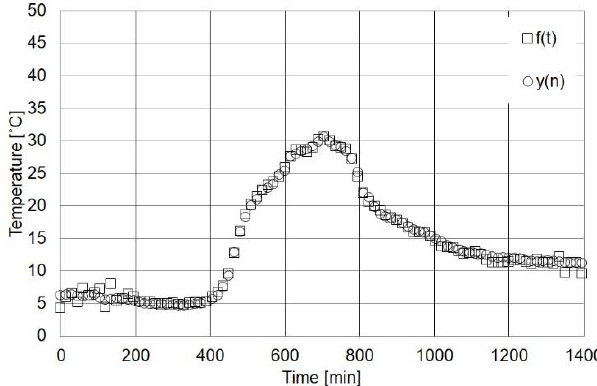
Figure 9. Measured temperature data points versus the continuous function provided by the signal reconstruction algorithm for an exposed wall in sunny winter conditions (ESW).